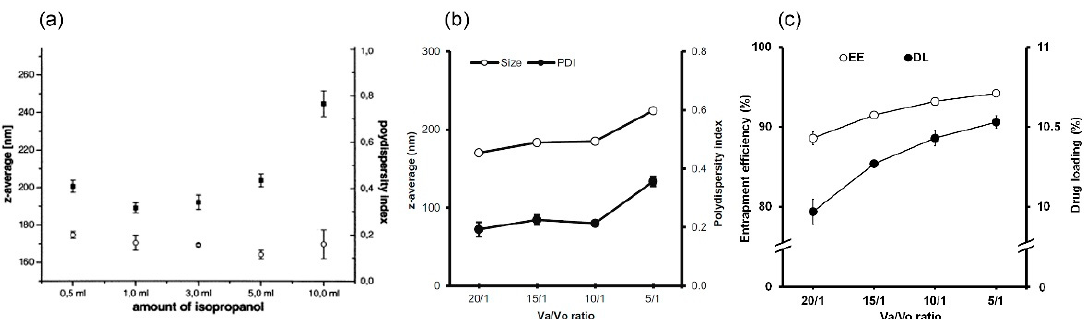
Figure 3. Effects of the ratio of aqueous phase to organic phase (Va/Vo ratio) on SLNs and NLCs. ( a ) Effects of Va/Vo ratio on PSs ( ● ) and PDIs ( ○ ) of SLNs. The aqueous volume was 60 mL, whereas the volume of isopropanol was varied from 0.5 to 10 mL. Reprinted from [36] with permission from Elsevier. ( b ) Effects of Va/Vo ratio on PSs and PDIs of ondansetron hydrochloride-loaded NLCs. Reprinted from [76] with permission from Elsevier, Copyright (2019). ( c ) Effects of Va/Vo ratio on EEs and DLs of ondansetron hydrochloride-loaded NLCs, data obtained from [76].